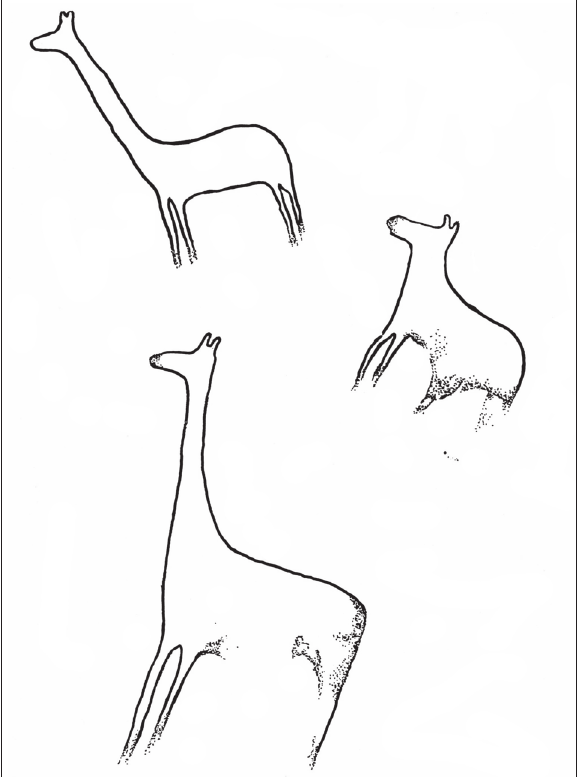
Tracings of giraffe rock art from Buffelshoekkloof, Kanetvlei, Hex River